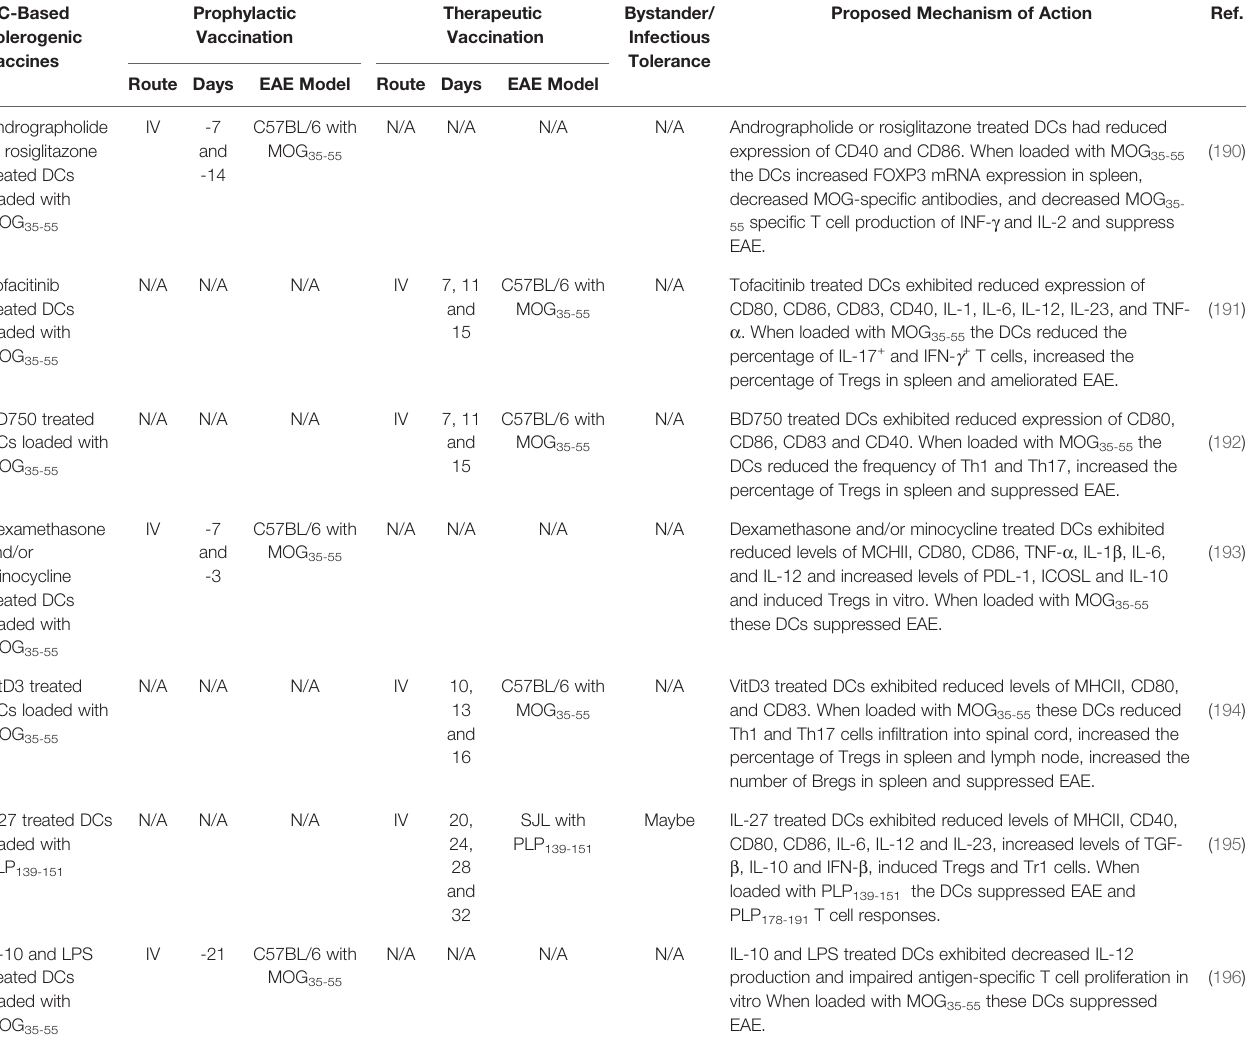
TABLE 5 | DC-based tolerogenic